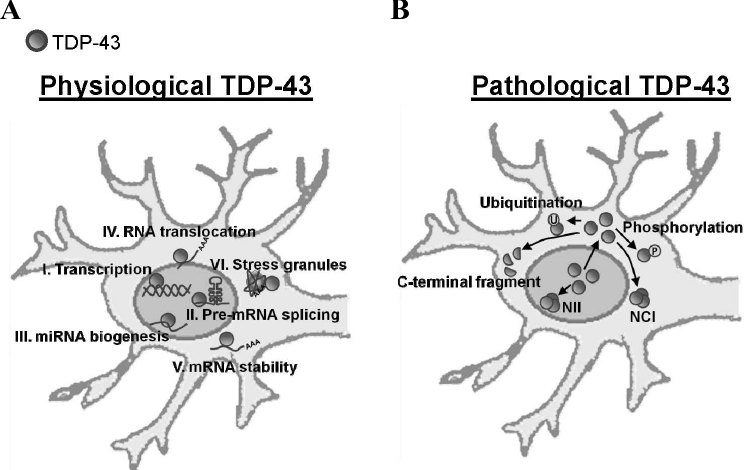
Figure 1. Expression of TDP-43 in physiological and pathological conditions. The upper panel shows the physiological functions of TDP-43, including transcription, pre-mRNA splicing, mRNA biogenesis, stress granules formation and mRNA stability. The lower panel shows the pathological expressions of TDP-43, which is predominantly sequestered in the cytoplasm, different from TDP-43 proteinopathy. ( A ) The roles of TDP-43 in the physiological neuron; ( B ) The morphologies of TDP-43 in the pathological neuron.